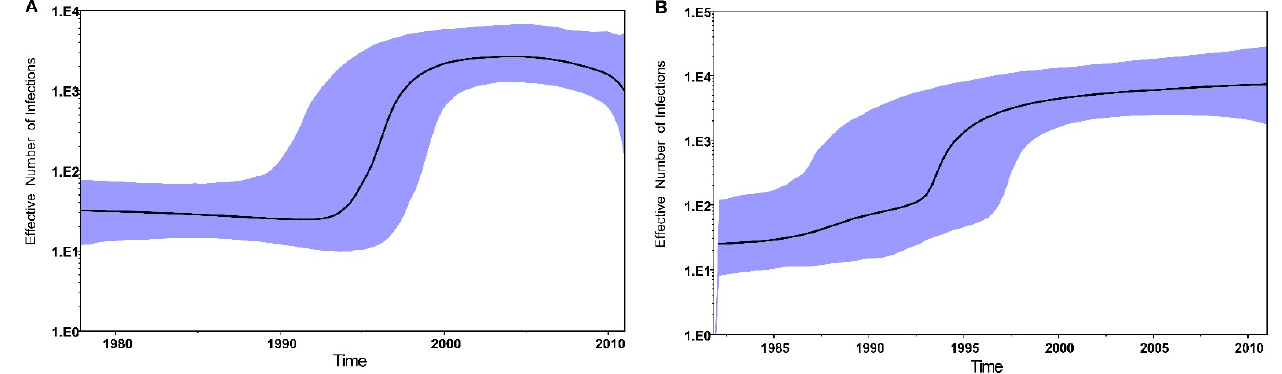
Figure 4. Bayesian skyline plot showing the predicted epidemic history of HCV GT-3a ( A ) and GT-3b ( B ) in China. The solid black line represents the estimated effective number of infections over time. The blue area indicates the 95% highest posterior density confidence intervals for this estimate.